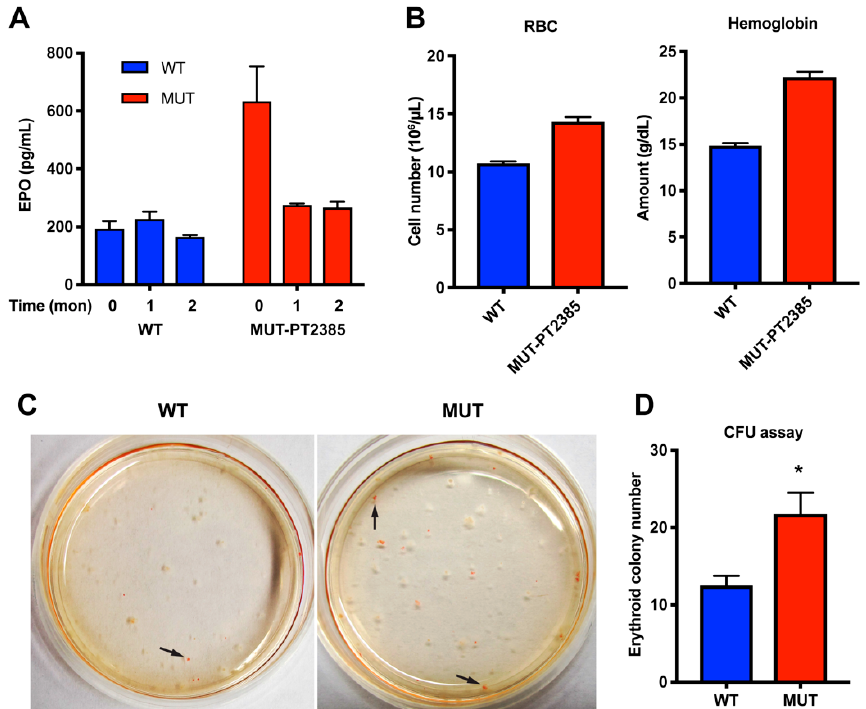
Figure 5. HIF2 α inhibition in the mutant mice. ( A , B ) PT2385 reduced EPO ( A ) but not polycythemia ( B ) in three–four-month-old Epas1 A529V mutant mice; n = 3 for each group. ( C ) Representative image of the colony-forming unit (CFU) assay. Arrows indicate the erythroid colonies. ( D ) Summary of the erythroid colonies from bone marrow CFU assay; n = 3 for each group. * p < 0.05.